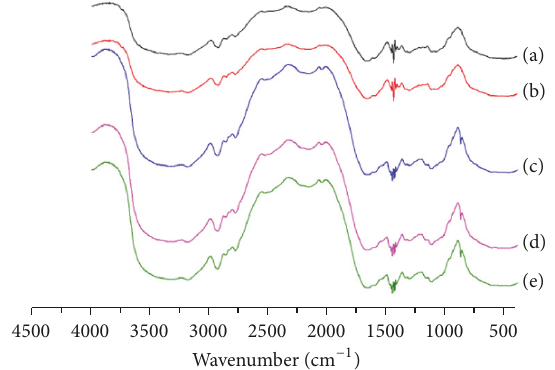
Figure 2: FTIR spectra of octadecyl methacrylate-acrylamide- N,N 󸀠 -bis(acryloyl)-cystamine hydrogel (concentration of octadecyl methacryl (a) 3%, (b) 4%, (c) 5%, (d) 7%, and (e) 9%).